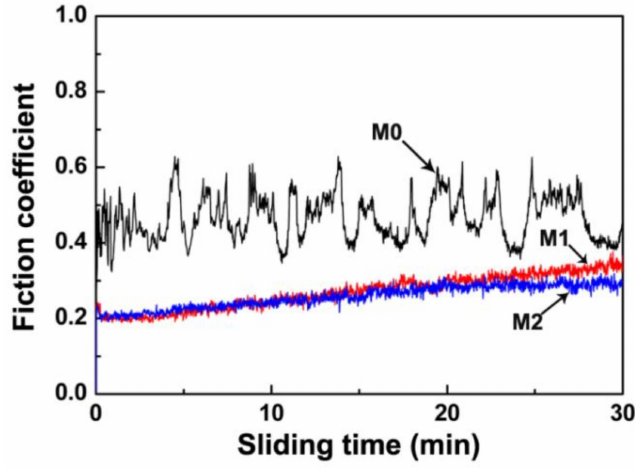
Figure 5. Friction coefficient curves of all fabricated